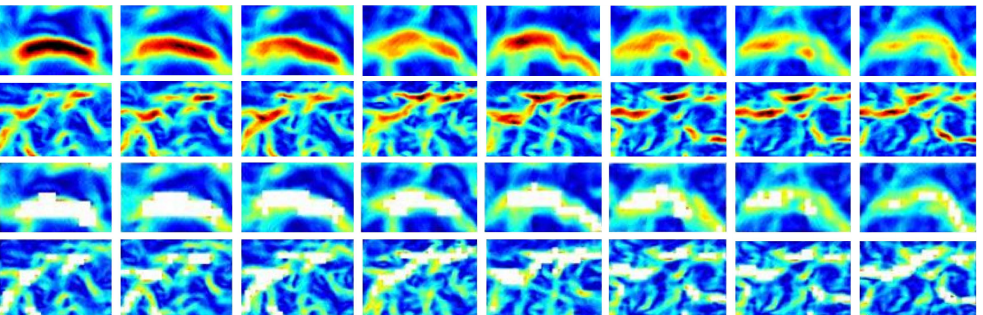
Figure 10. The ocean-front trend example. From the top to bottom is an ocean-front attenuation video sequence, an ocean-front enhancement video sequence, an ocean-front attenuation video sequence tracking label, and an ocean-front enhancement video sequence tracking label.